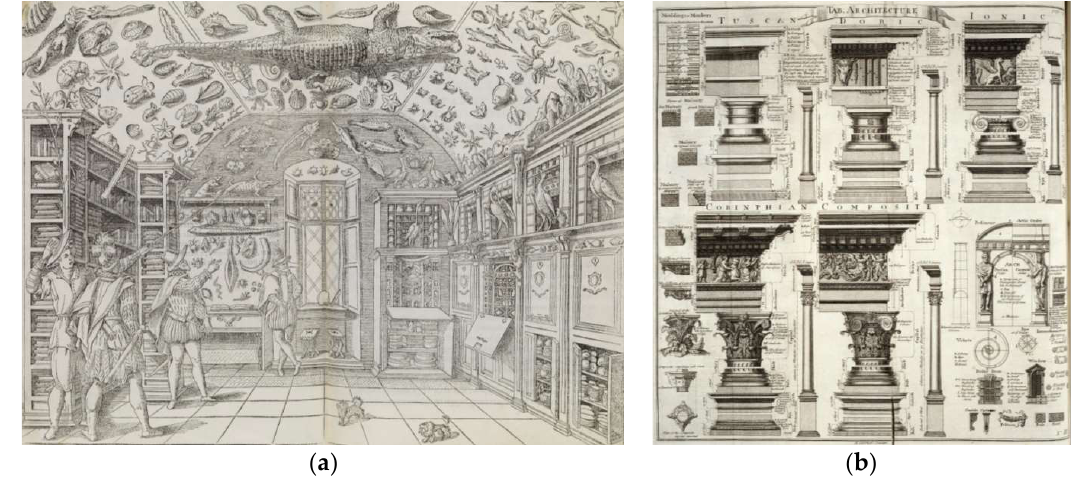
Figure 4. ( a ) Imperato, F. Dell’historia naturale , 1599, Wunderkammer ; ( b ) Chambers, E. Cyclopedia , 1728, orders of